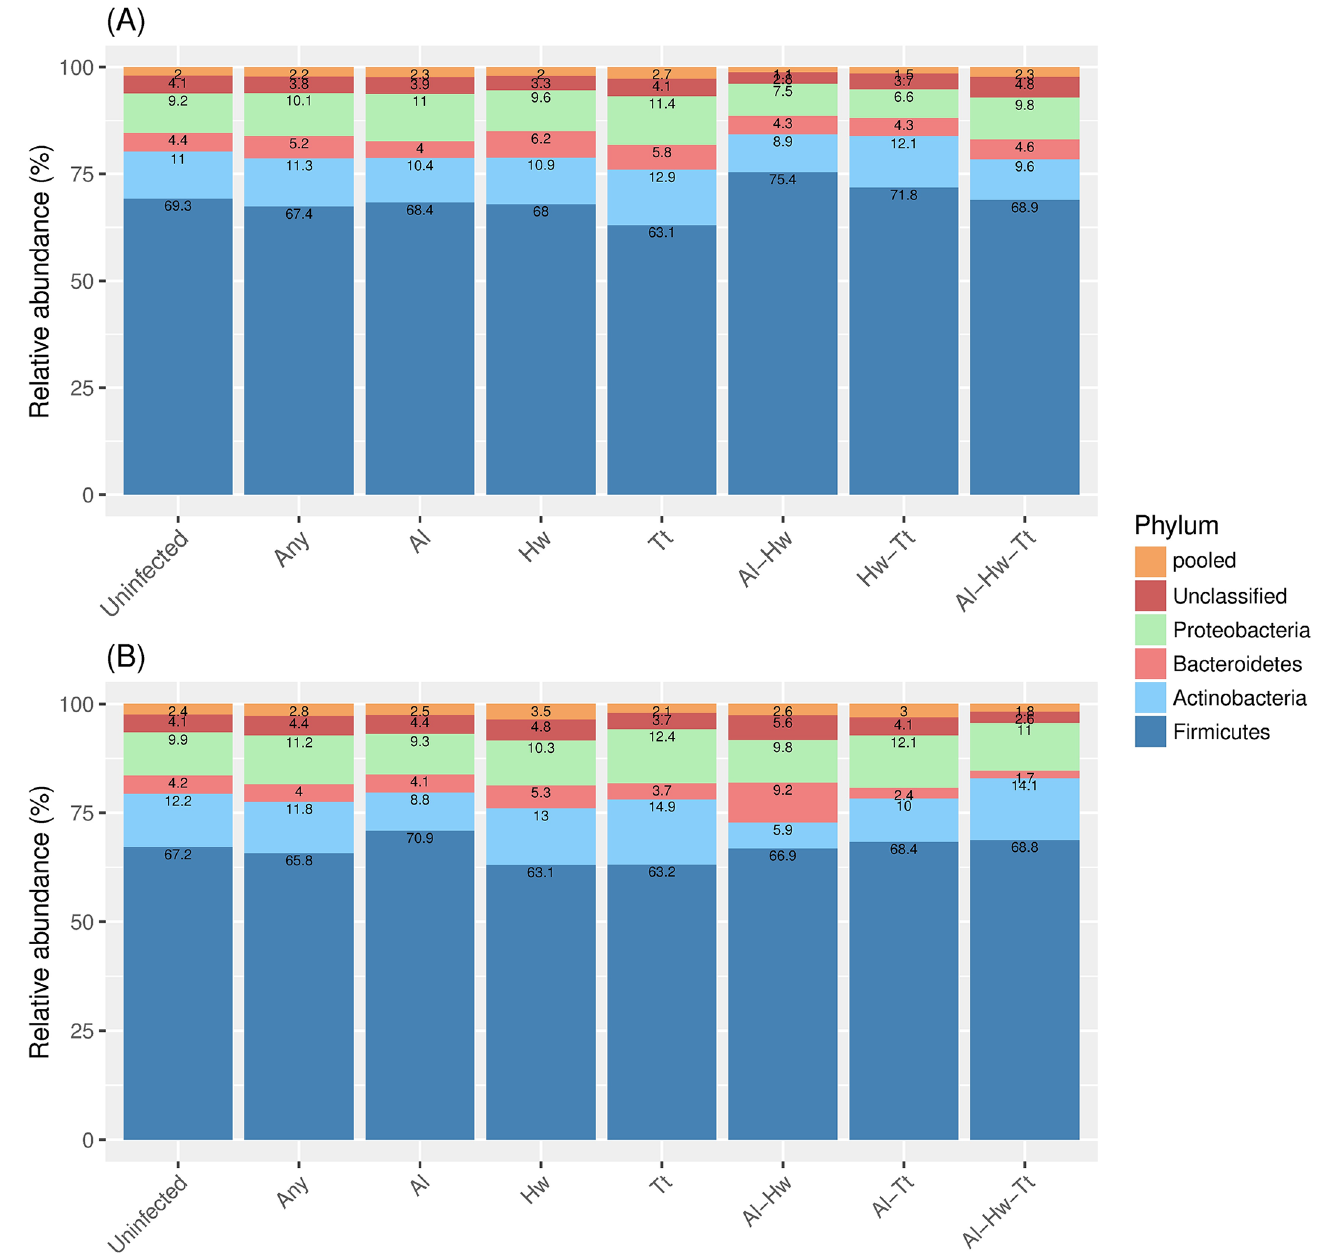
Fig 4. The microbiome composition at pre-treatment (A) and post-treatment (B) stratified by helminth infection. The stacked bar plots represent the relative abundance for each of the most abundant phyla where the Unclassified represents the category of sequences that could not be assigned to a phyla, and the pooled category consists of the remaining 13 phyla with average relative abundance less than 1%. The numbers inside the stacked bar plots show the relative abundance of the specific taxa. The microbiome compositions were depicted for group of helminth-uninfected (Uninfected), any helminth infected (Any), single helminth infection ( A . lumbricoides (Al), hookworm (Hw) or T . trichiura (Tt)), double infection (Al—Hw, Al—Tt and Hw—Tt) or triple infections